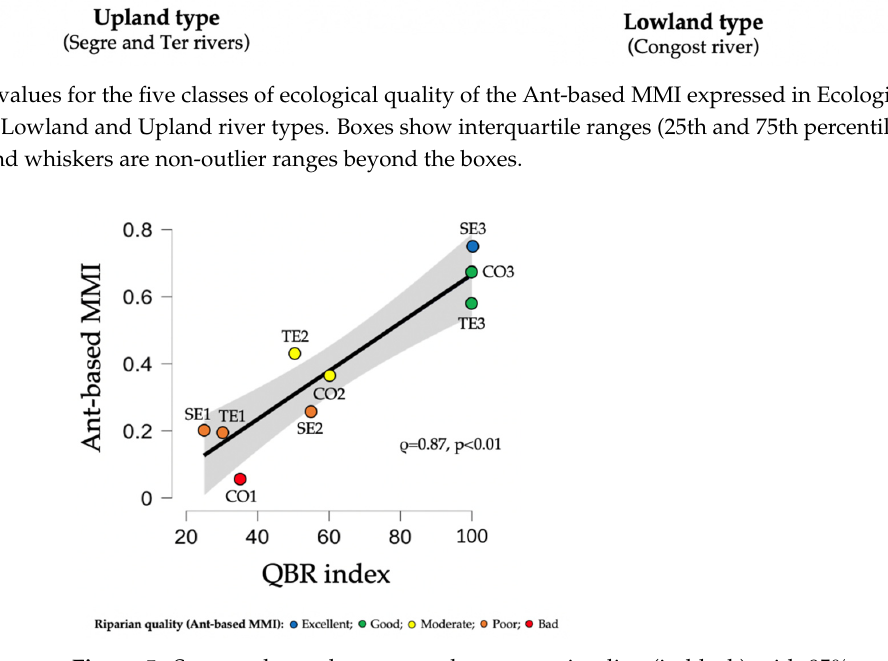
Figure 5. Scatter plot and correspondent regression line (in black) with 95% confidence interval (shaded area) representing the relationship between the Ant-based MMI and the QBR index. Spearman’s ρ correlation test revealed a significant positive correlation between the two indices. Table 4. Summary table of agreement between Ant-based MMI and the QBR index for the assessment of riparian quality. River Type Disturbance Group